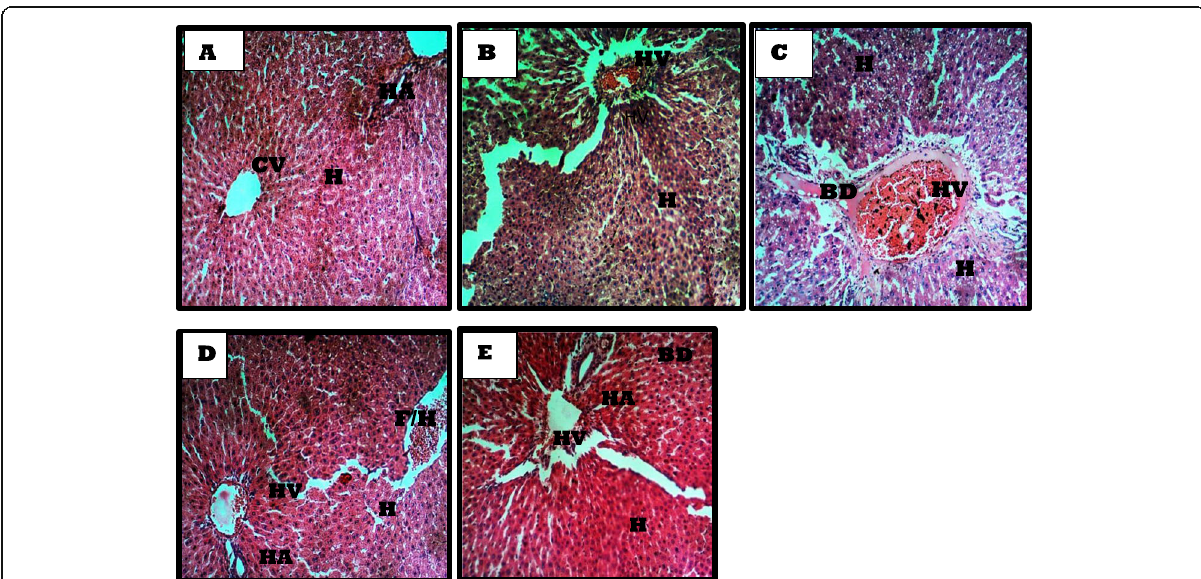
Fig. 1. a - e (400X): Photomicrograph of Liver. CV- Central vein, H- Hepatocyte, HA- hepatic artery, HV- Hepatic vein, BD- bile duct, F/H- Fibrosis/ Hemorroids. a (Group A) - Photomicrograph showed normal cyto-architectural presentation of the hepatocytes and normal portal triad composed of the hepatic vein, hepatic artery, and bile duct. b (Group B) - Photomicrograph showed severe hemorrhagic cells, congestion of blood in the hepatic vein, widening of sinusoids, and infiltration of inflammatory cells as compared with the control group. c (Group C) - Photomicrograph showed severe hemorrhagic cells and some fibrosis. d (Group D) - Photomicrograph showed mild fibrosis, widening of sinusoids, heavy congestion of central vein, some regenerative changes in hepatocytes and mild distortion of the hepatic artery. e (Group E) - Photomicrograph showed pronounced widening of sinusoids, mild congestion of central vein, mild fibrosis, and more regenerative changes in